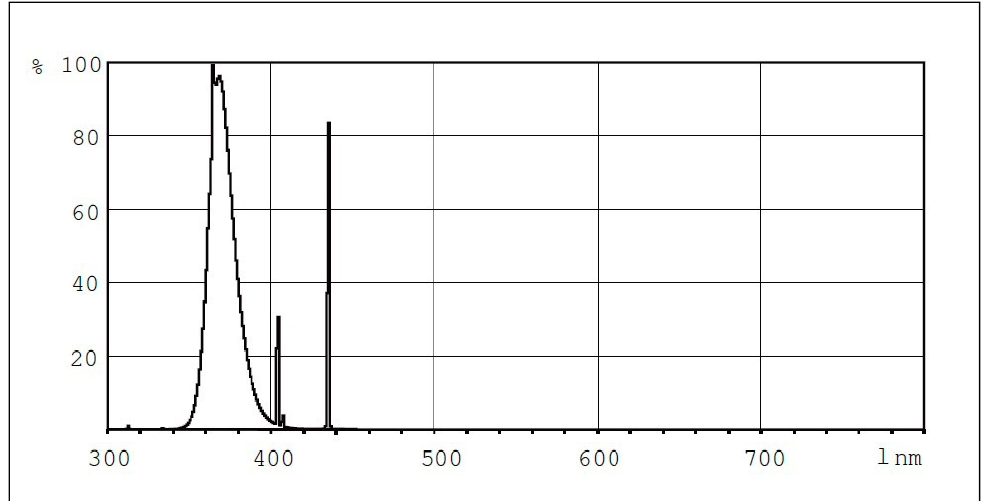
Figure 2. Spectral power distribution of UV-A lamps used in the second experiment in the UV-block greenhouse.